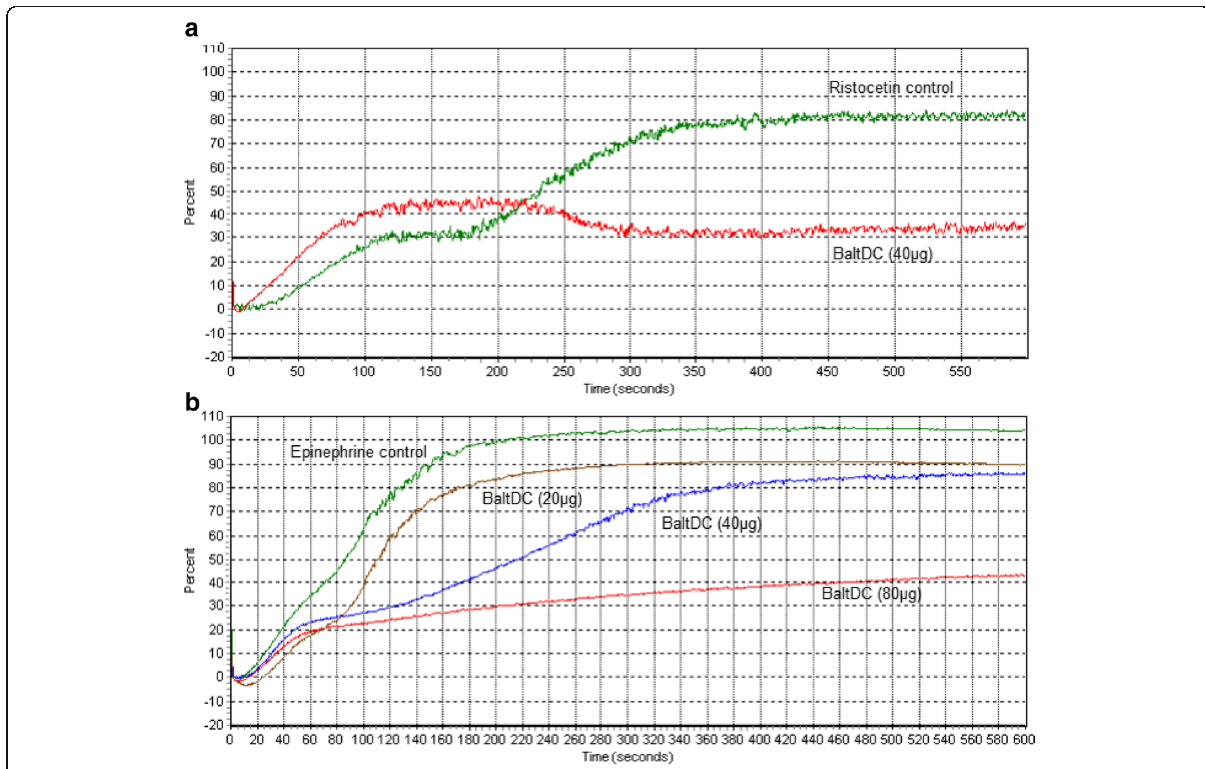
Fig. 3 Effect of BaltDC on (a) ristocetin and (b) epinephrine-induced platelet aggregation. PRP was preincubated with BaltDC for 30 min at 37 °C before adding agonists. Platelet aggregation was recorded for 10 min in an AggRAM platelet aggregation system with four-channel laser optics (Helena Laboratories, EUA). Results were expressed as an increase in light transmission. Control experiments were performed using only platelet